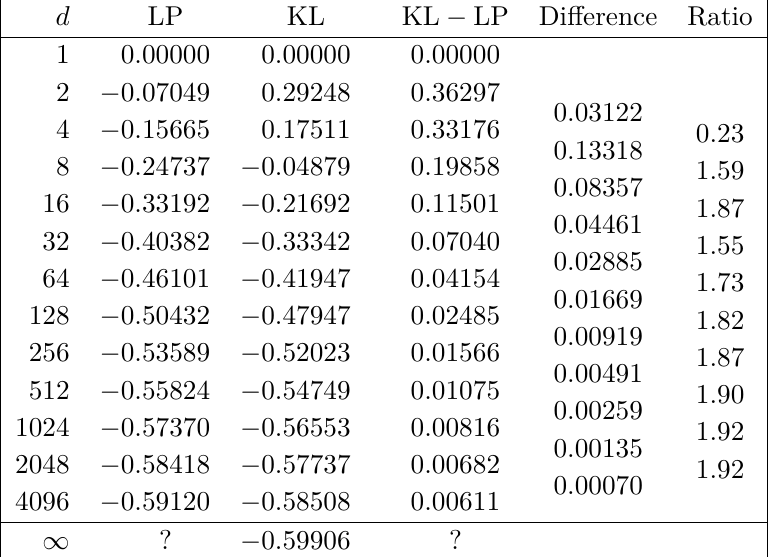
Table 1 . Numerical comparison of the linear programming bound in R d (denoted LP) with the Kabatyanskii-Levenshtein bound (denoted KL). The bounds are in the form (log are rounded rather than